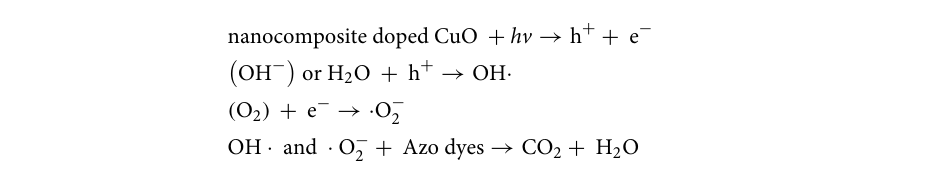
Figure 15. Reversibility of CPA/N-SWCNTs-GO-CE/CuO particles based on the bleaching and degradation rates of MO